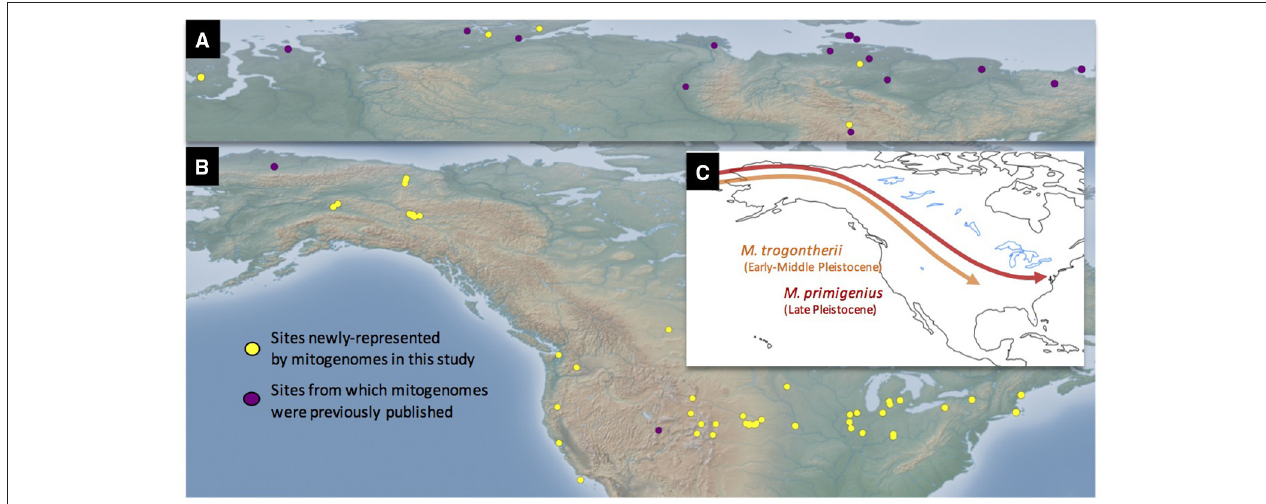
FIGURE 1 | Site locations represented in this study and schematic models of Mammuthus immigrations into North America. Sites in both the Old (A) and New (B) Worlds are depicted. Conventionally, two mammoth species have long been recognized in the Late Pleistocene fossil record of North America, the Columbian mammoth Mammuthus columbi and the woolly mammoth M. primigenius . Some authors support the hypothesis that these species developed from different ancestral taxa within Mammuthus , the southern mammoth M. meridionalis giving rise to the Columbian mammoth, and the steppe mammoth M. trogontherii to the woolly mammoth. In contrast to this dual-source model, the single-source model posits that both M. columbi and M. primigenius descended from M. trogontherii , but at different times and from different geographical populations of the latter species (see text) (C) . The mitogenomic evidence explored in this paper is more consistent with the single-source